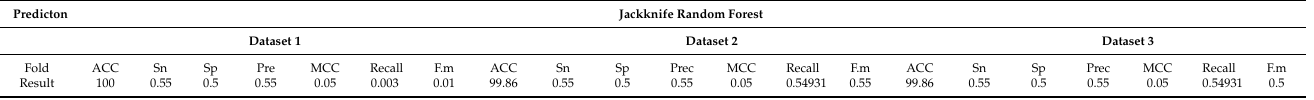
Table 5. Jackknife score based on the Probabilistic Neural Network.